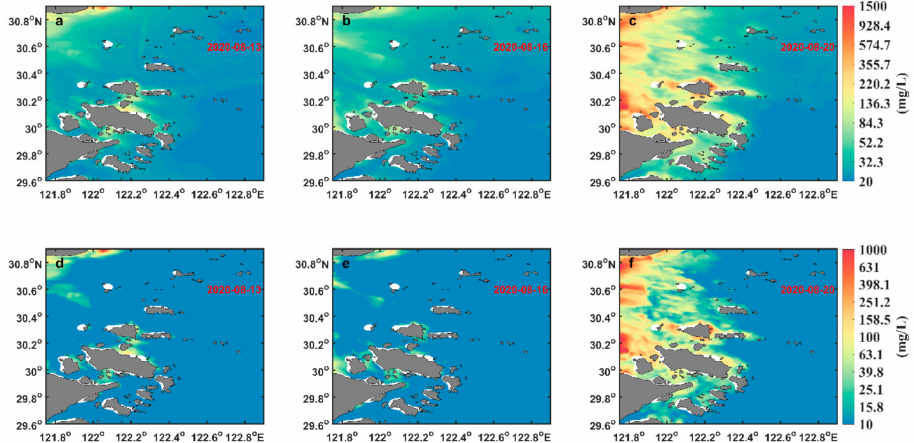
Figure 8. The daily averaged SSC during neap ( a ), middle ( b ), and spring tides ( c ), respectively. ( d – f ) show the corresponding standard deviation (STD).